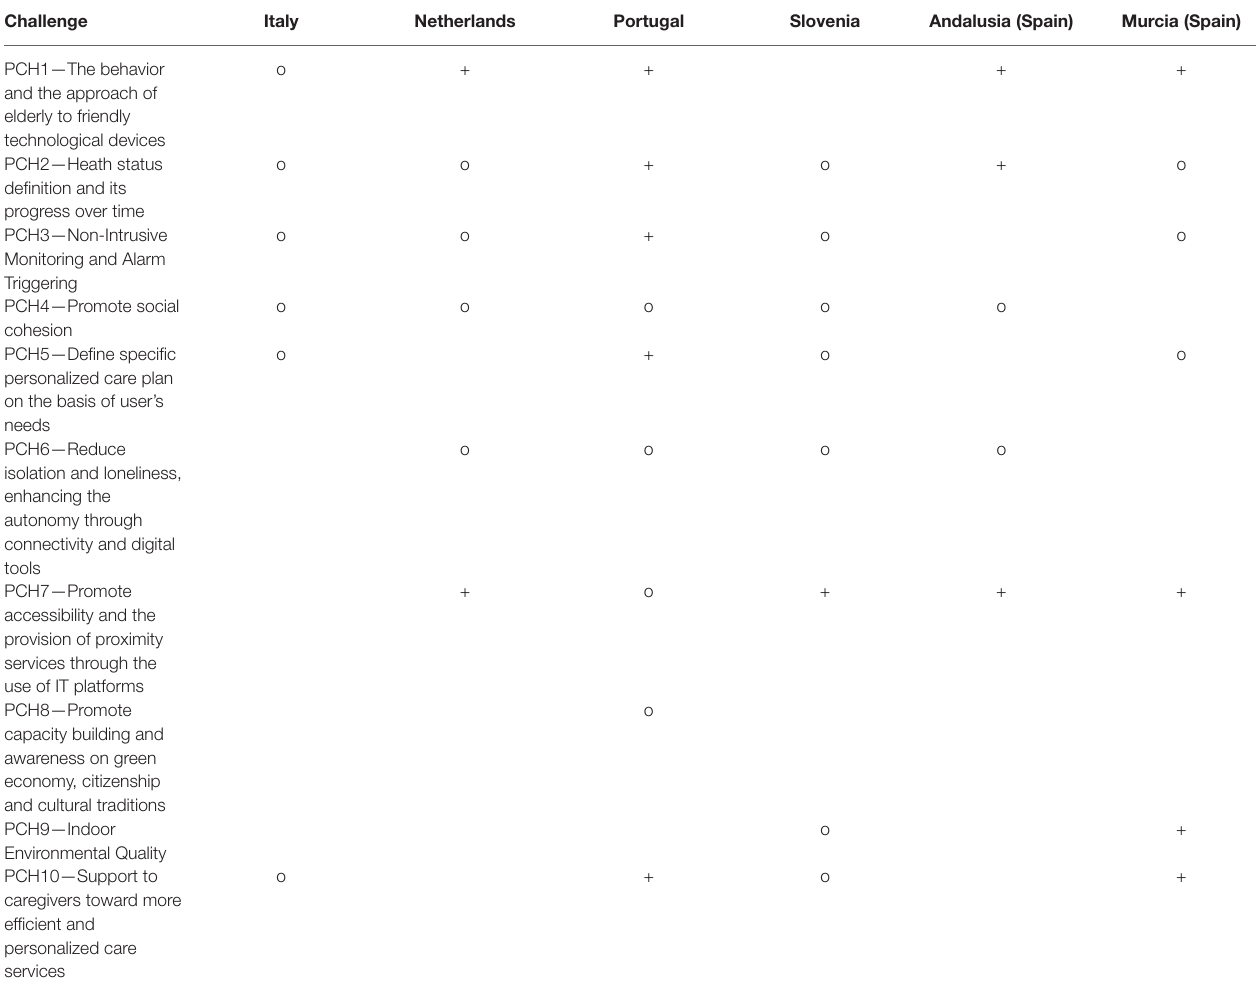
TABLE 3 | Challenges of the ecosystem addressed by the pilot